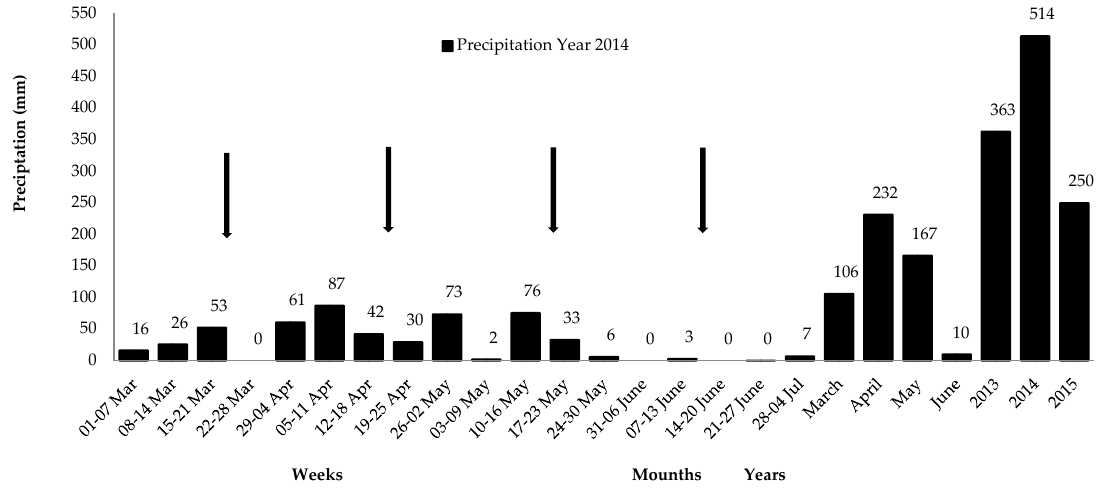
Figure 1. Weekly and monthly precipitation from March to June 2014 and yearly precipitation during the assessment in 2013, 2014, and 2015. † Arrows indicate collection weeks in each month. Source: [22].